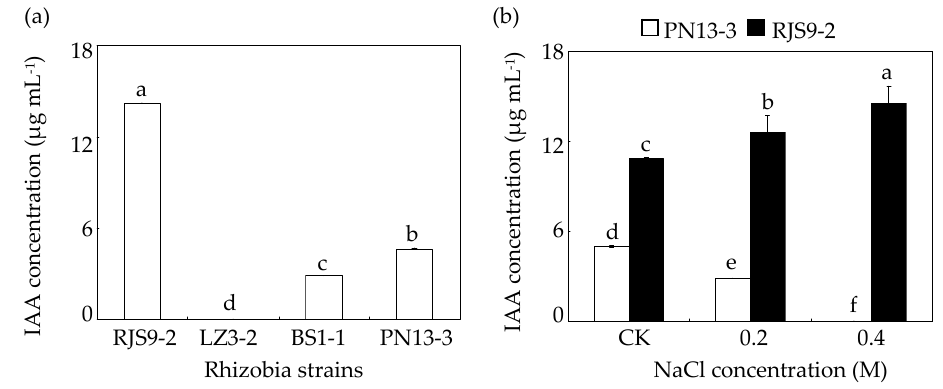
Figure 3. Indole-3-acetic acid (IAA) concentrations in rhizobia at various NaCl levels. ( a ) IAA concentrations in the four tested strains in the absence of NaCl treatment; ( b ) IAA concentrations in PN13-3 and RJS9-2 under various NaCl concentrations. Bradyrhizobium strains were separately inoculated into liquid medium containing 0.0017 (CK), 0.2, or 0.4 M NaCl and further incubated at 28 °C and 180 rpm. The IAA concentrations in the culture medium were detected after 8 days of NaCl treatment. A column represents mean value obtained from three biological replicates and bar represents standard error. An individual flask was considered one biological replicate. The same letter indicates no significant difference at p < 0.05 (Duncan’s test).